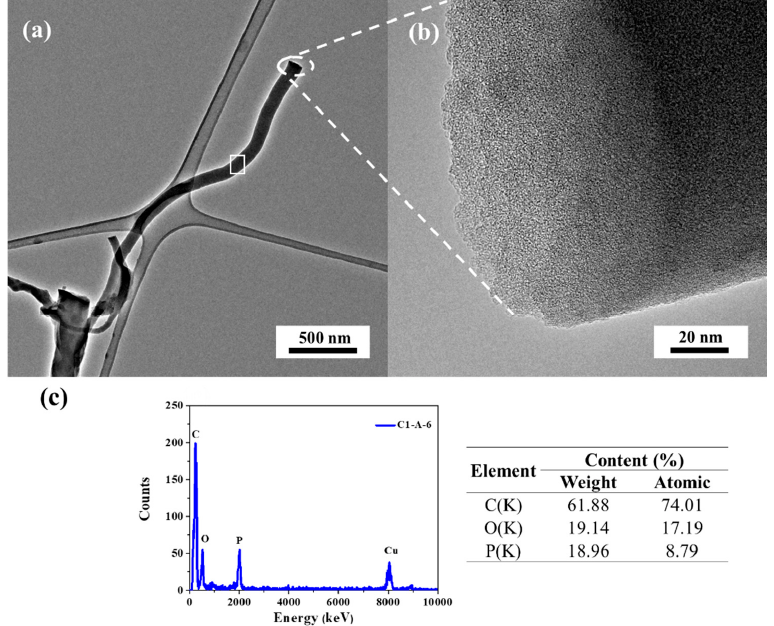
Figure 2. ( a , b ) High-resolution transmission electron microscope (HRTEM) images of a C1-A-6 sample with different magnifications and ( c ) energy dispersive X-ray spectrometer (EDX) elemental profiles and composition.